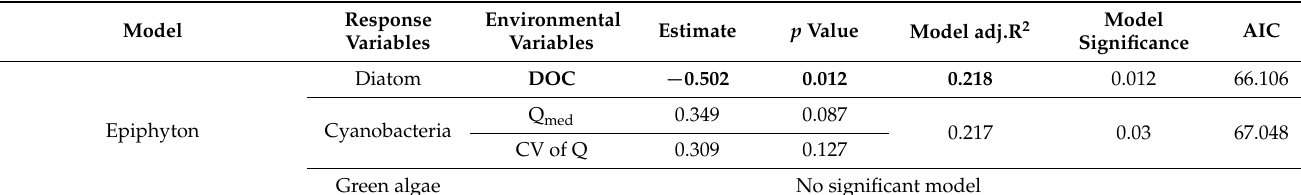
Table 2. Multiple regression models on algal composition in epiphyton and epilithon ( p < 0.05 and lowest AIC). Significant variables in the models are shown in bold. All environmental data derived from measurements taken in the period of 21 days before sampling date (Figure